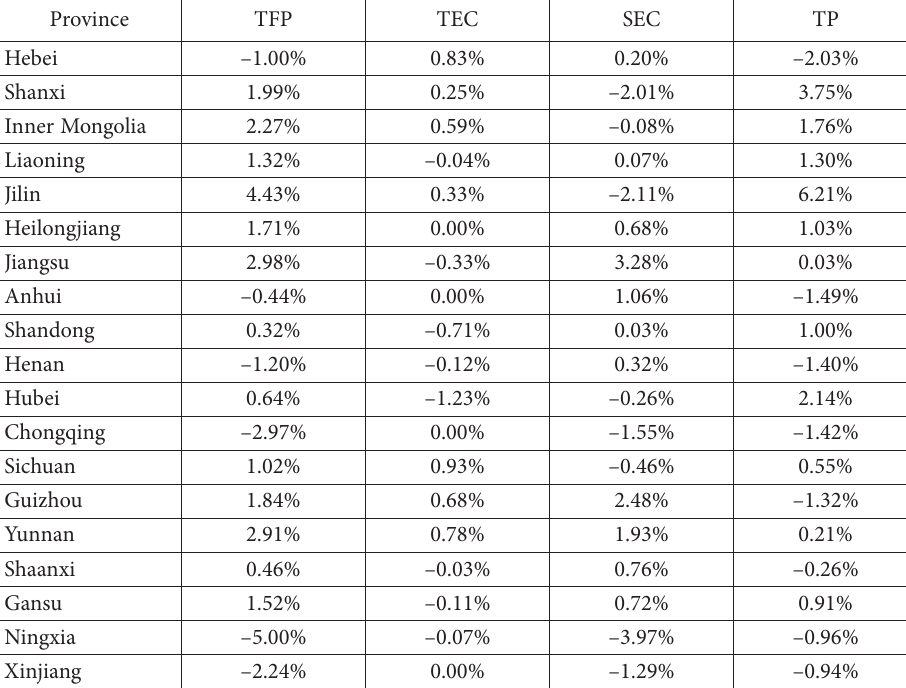
Table 3. Annual average provincial growth rates of the TFP indicator and its decomposition (2004– 2017)